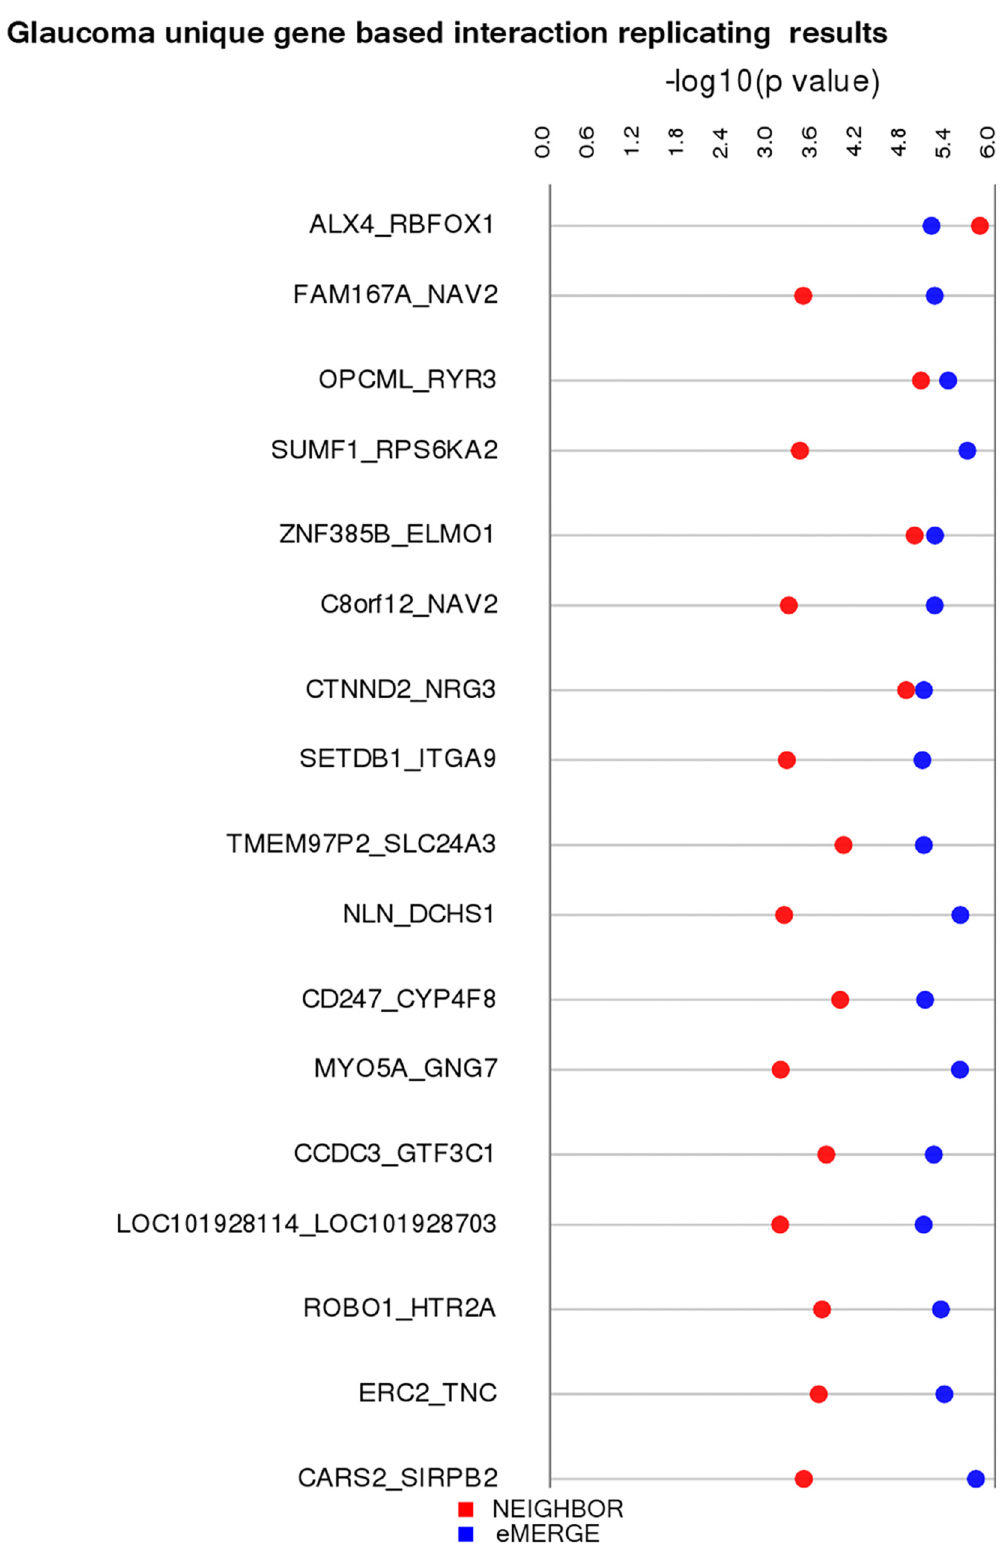
Fig 3. Synthesis view plot representing unique gene-gene interaction models and their p-values in discovery and replication dataset.